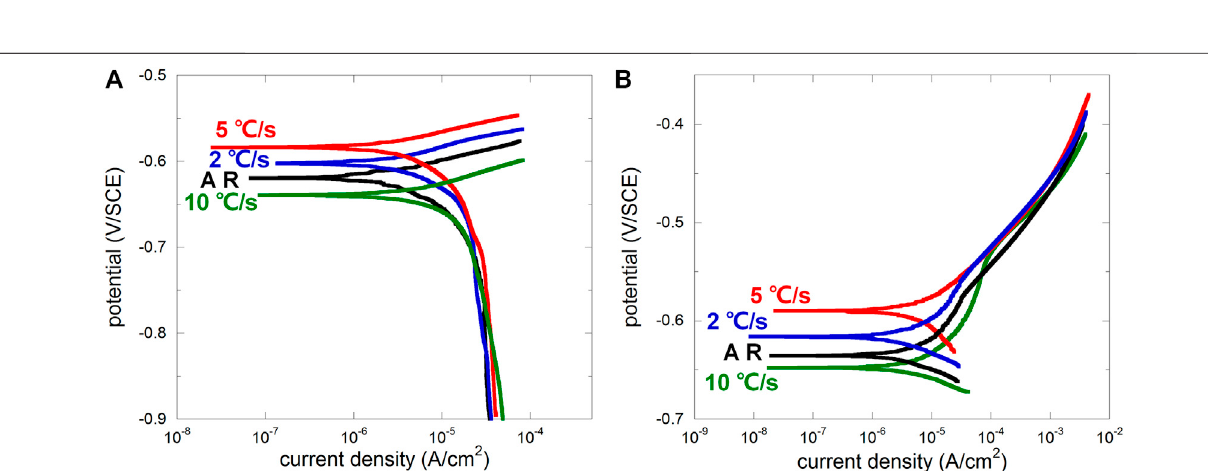
Frontiers in Materials |